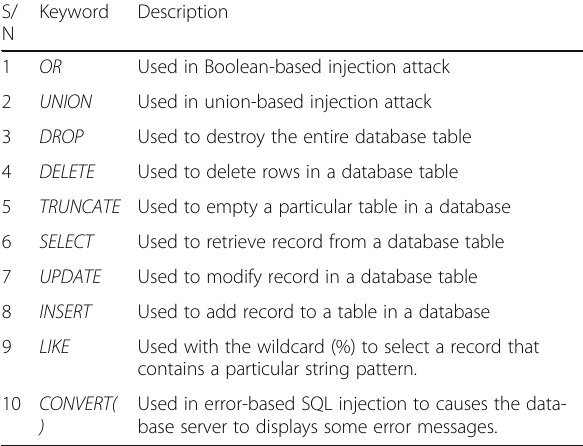
Table 2 Keywords used to compose SQL-injection